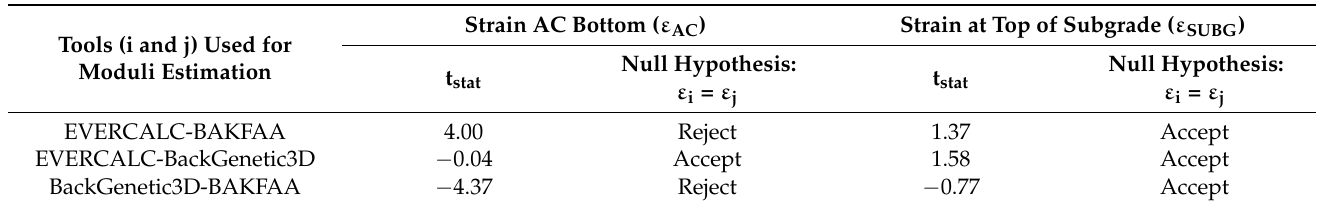
Table 3. Paired t -test with 41 degrees of freedom ( t crit = 2.02) for the assessment of strain differences. Strain AC Bottom ( ε AC ) Strain at Top of Subgrade ( ε SUBG ) Tools (i and j) Used for Null Hypothesis: Null Hypothesis: Moduli Estimation t stat t stat ε i = ε j EVERCALC-BAKFAA 4.00 EVERCALC-BackGenetic3D −